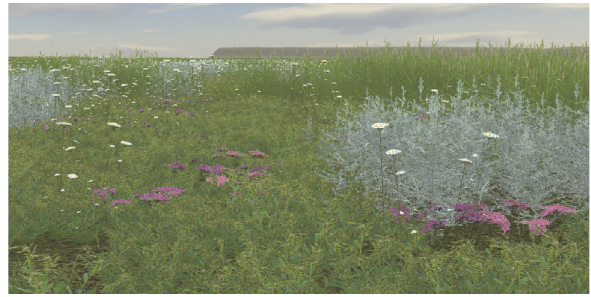
Figure 18: Close-up view of the plant models in the virtual